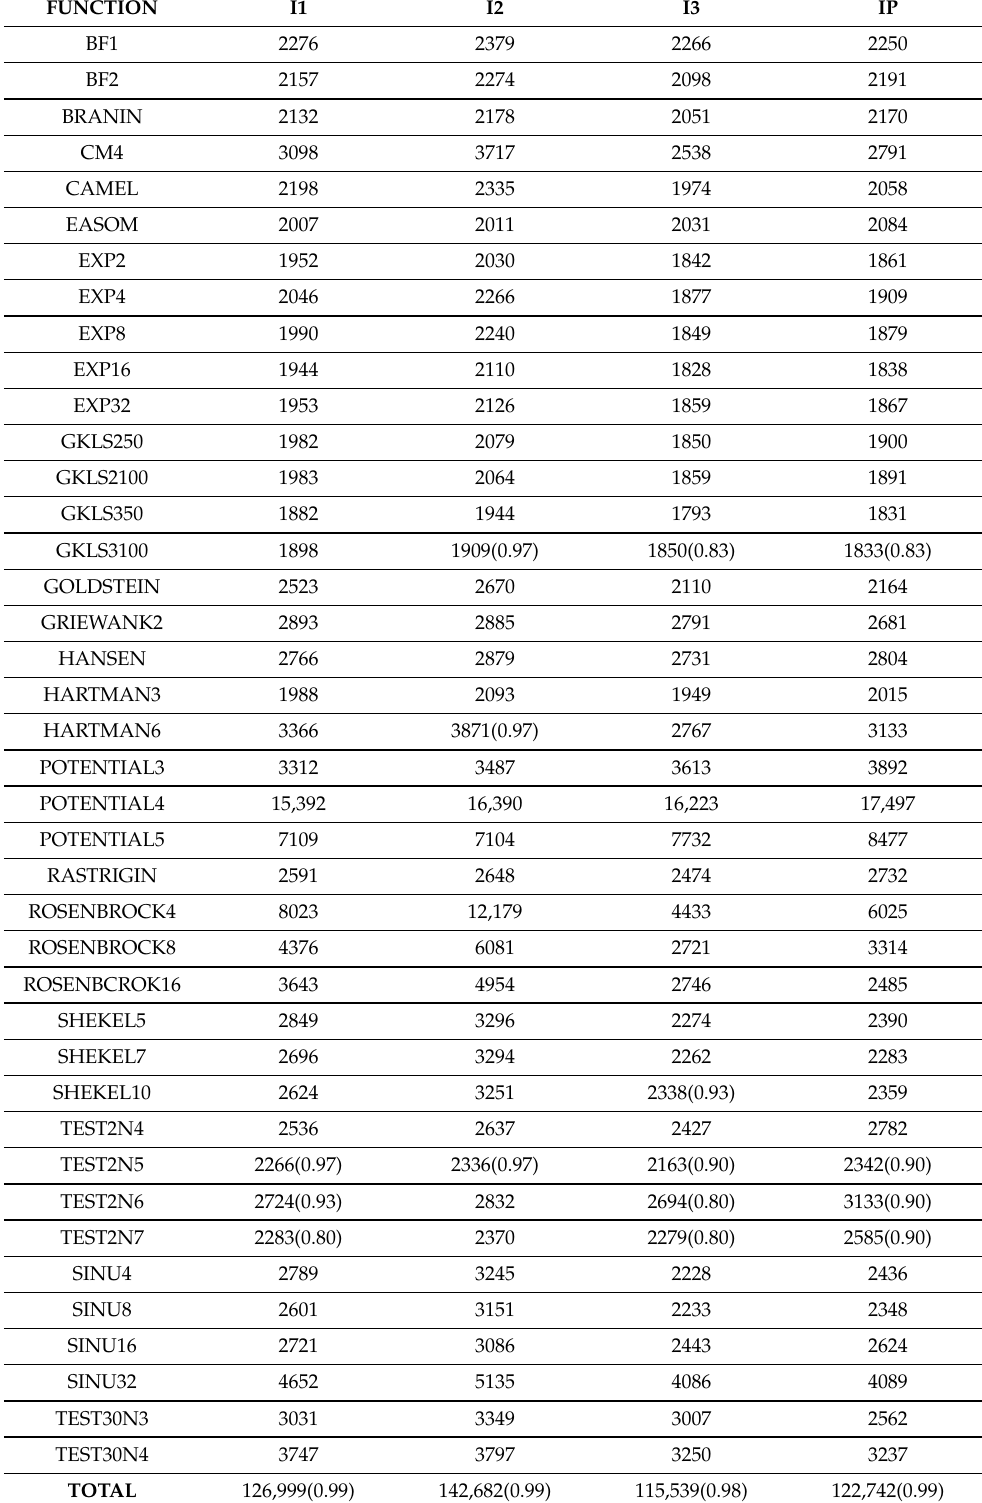
Table 7. Experiments with the proposed stopping rule with the gradient check